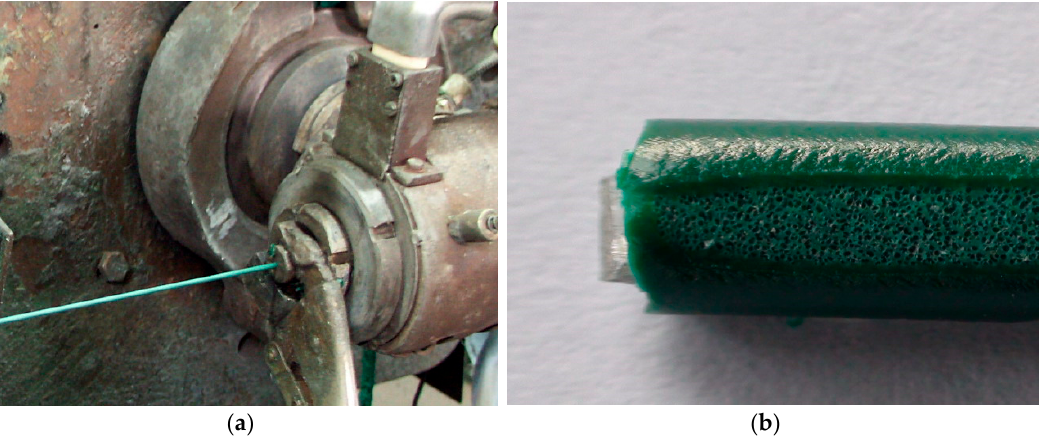
Figure 1. Fragment of the produced metallic wire with a polyvinyl chlorine (PVC) coating: ( a ) Producing coated wire with a single layer coating in an amount of 0.4% of a blowing agent (BA); ( b ) Fragment of the longitudinal section of the double coatings PVC + 0.6% BA.